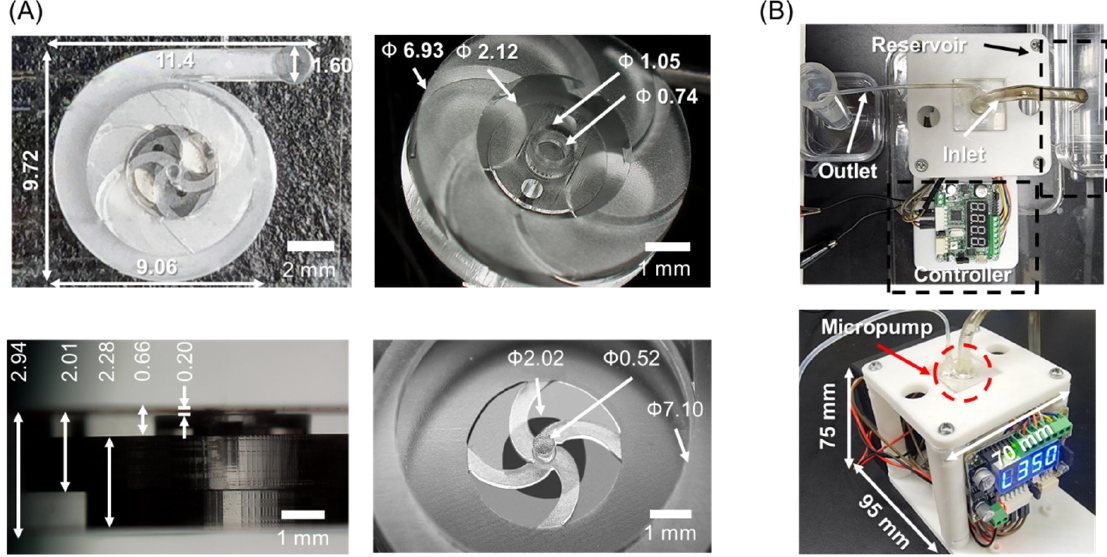
Figure 4. ( A ) Fabricated glass micropump and ( B ) performance test setup.